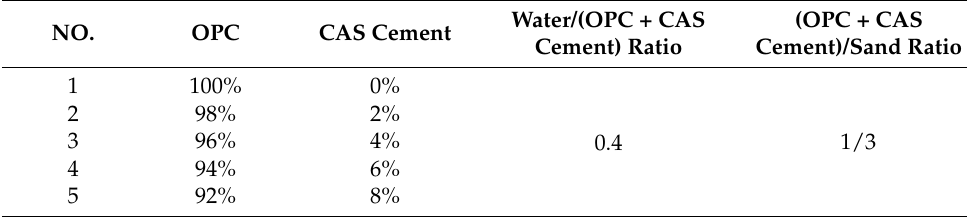
Table 2. The mixing proportion of cement